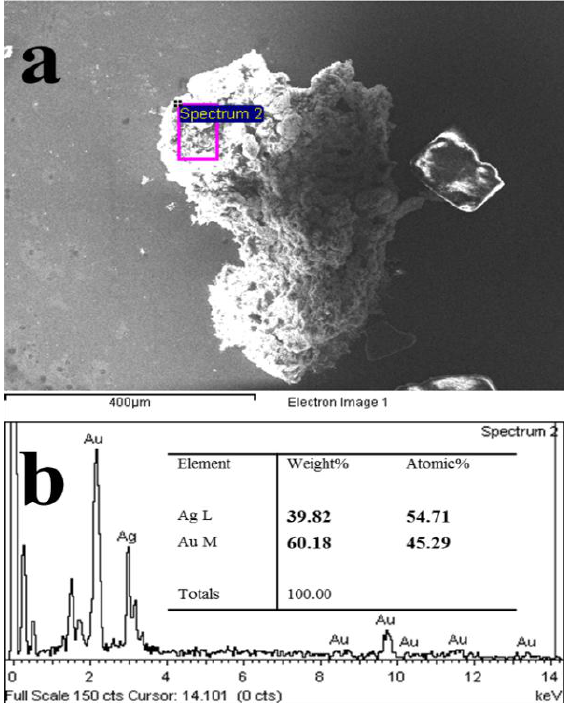
Figure5. ( a ) Au-Ag NWs showing the square scanned area and ( b ) Energy-dispersive X-ray EDX spectra of the Au-Ag NWs.